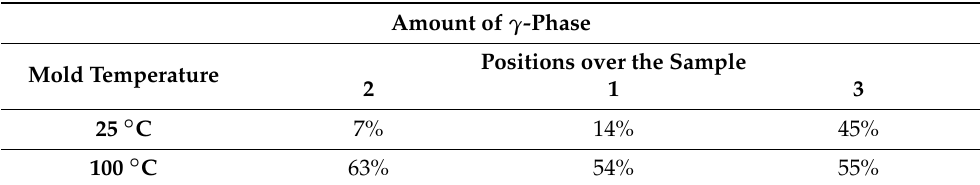
Table 1. Fraction of γ -phase in 3 wt% MWCNT nanocomposite manufactured at mold temperature 25–100 ◦ C and in the different positions over the samples. Amount of γ - Phase Mold